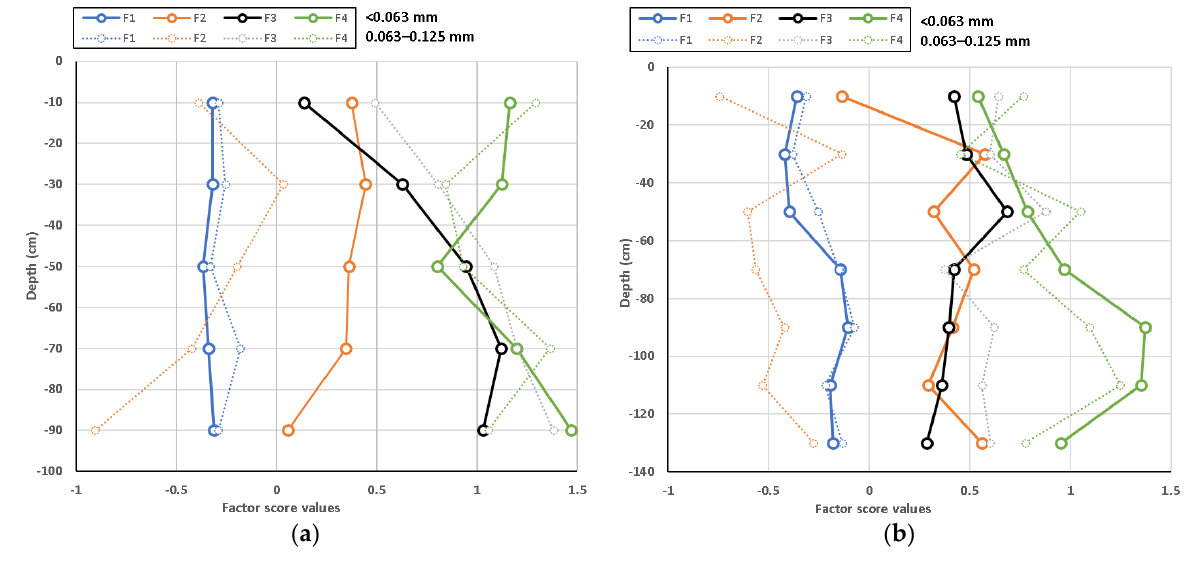
Figure 6. Factor score values in the profiles through alluvial sediments of the Savinja river, above ( a ) and below ( b ) the affluent with the Voglajna river.